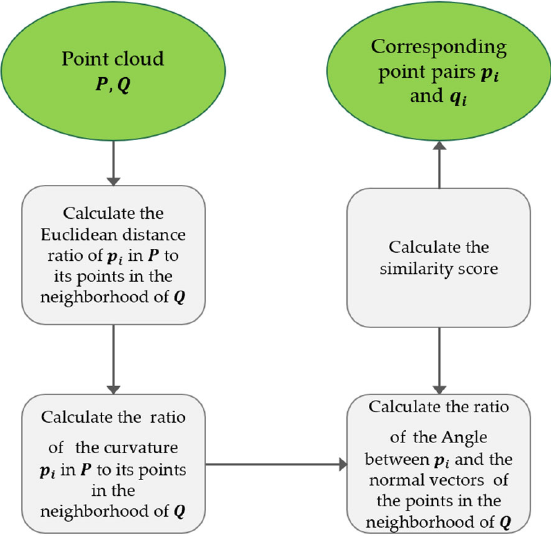
Figure 7. Multi-scale constraint description matching Figure 7. Multi ‐ scale constraint description matching search.